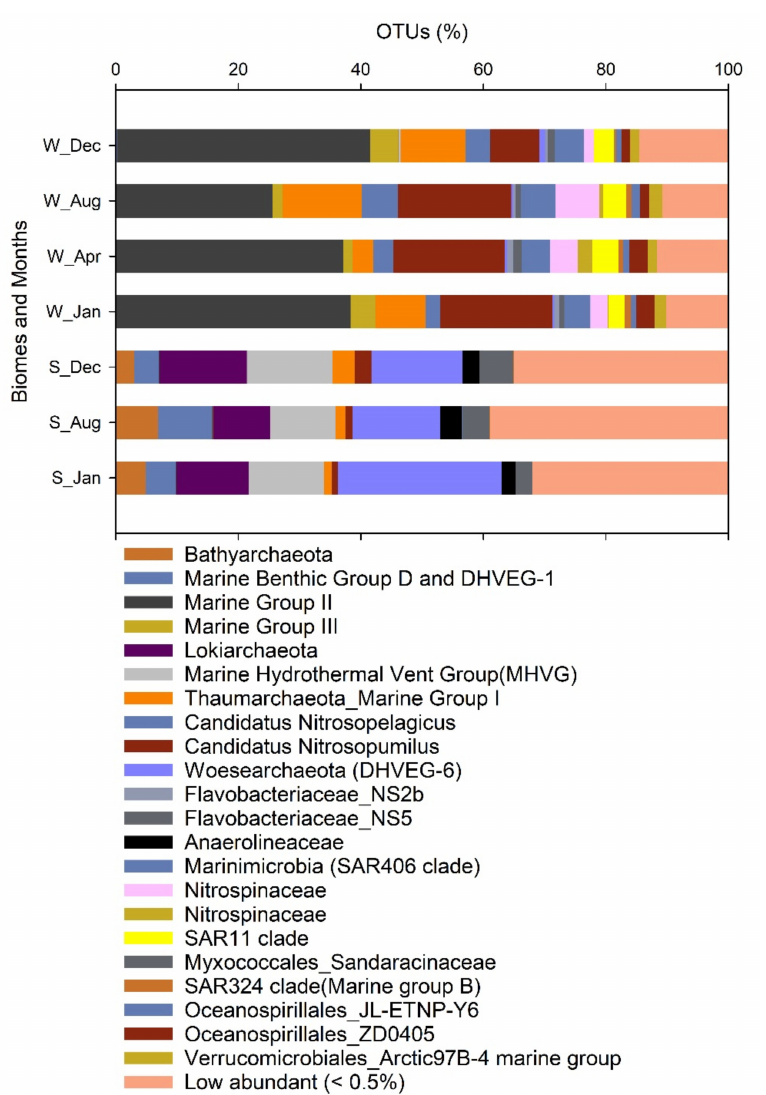
Figure 7. Operational taxonomic units (OTUs) contribution to the libraries in the different biomes Sediment and Water (S_ and W_) and sampling